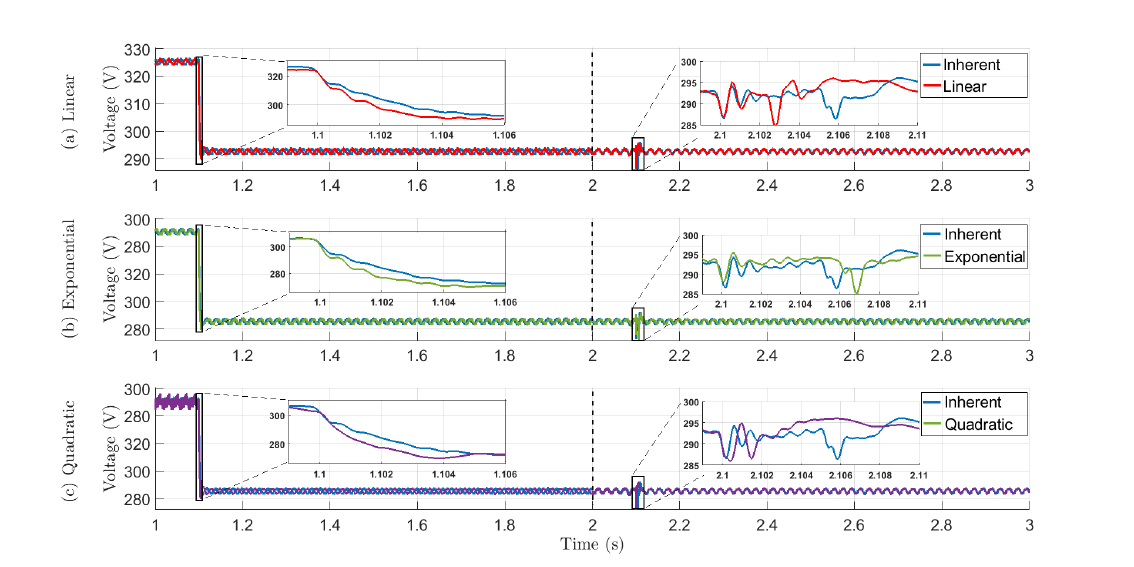
Figure 7. Dynamic response evaluation of SPAACE under the islanded mode of operation. SPAACE is implemented outwith the DER